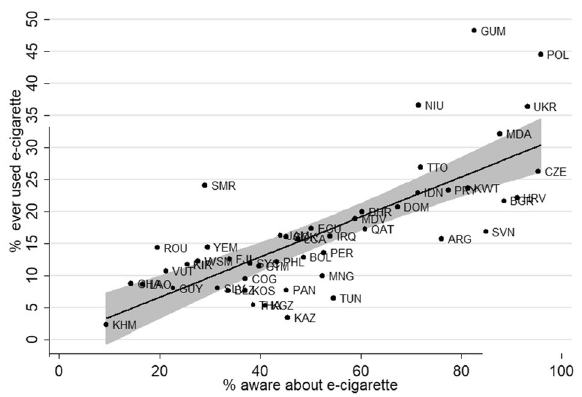
Figure 1. Two-way scatter plots between the prevalence of awareness and ever e-cigarette use (both sexes) in 49 countries. Cambodia- KHM, Ghana-GHA, Lao republic-LAO, Romania-ROU, Vanuatu-VUT, Guyana- GUY, Kiribati-KIR, Samoa-WSM, San Marino-SMR, Yemen-YEM, El Salvador-SLV, Belize-BLZ, Fiji-FJI, Kosovo-KOS, Congo-COG,Seychelles-SYC,Thailand-THA,Guatemala-GTM,Kyrgystan-KGZ,Philippines- PHL,Jamaica-JAM,Panama-PAN,Cook islands-COK, Kazakhstan-KAZ, Saint Lucia-LCA,Bolivia-BOL,Ecuador- ECU,Mongolia-MNG,Peru-PER,Iraq-IRQ, Tunisia-TUN, Maldives-MDV, Bahrain-BHR, Qatar-QAT, Dominican Republic-DOM, Indonesia-IDN, Niue-NIU, Trinidad and Tobago-TTO, Argentina-ARG, Paraguay- PRY, Kuwait-KWT, Guam-GUM, Slovenia-SVN, Republic of Moldova-MDA, Bulgaria-BGR, Croatia-HRV, Ukraine-UKR, Czech republic-CZE, Poland-POL. (Spacing after the comma should be consistently applied).